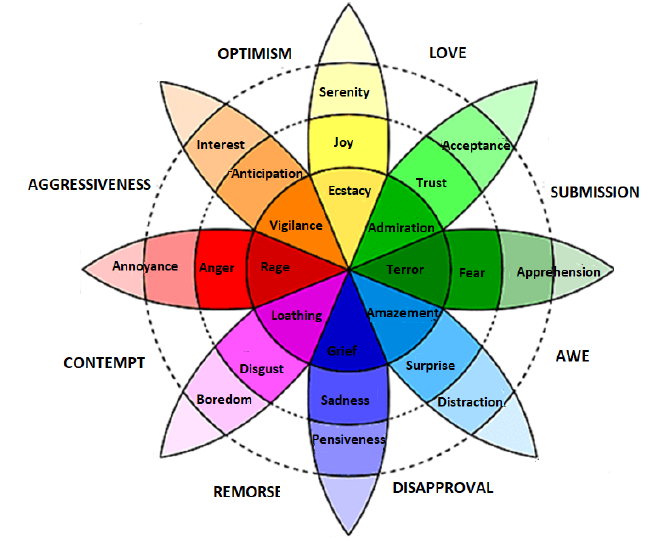
Figure 2. Plutchik wheel of discrete emotions